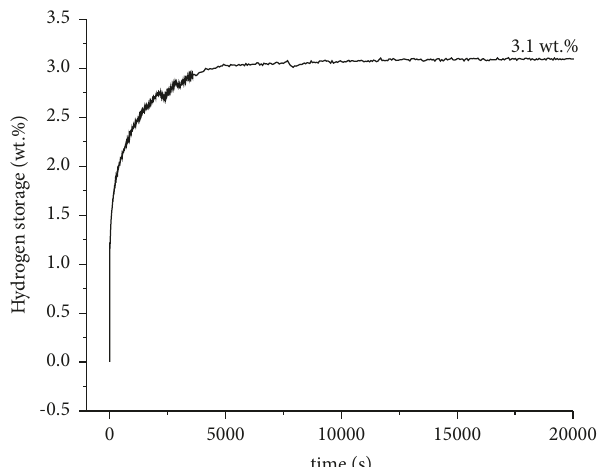
Figure 8: The kinetic curve of first activated hydrogen absorption after ball